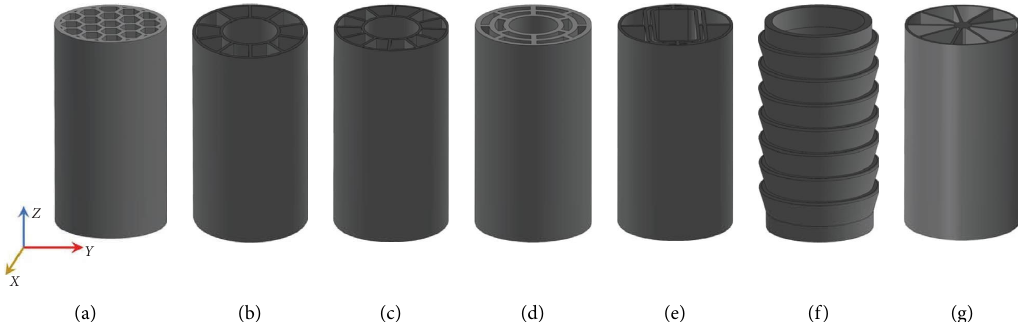
Figure 3: Te illustration of CAD models for nature inspired infll structures: (a) TIHIs, (b) HIIs-10, (c) HIIs-12, (d) BIIs, (e) CIIs, (f) PIIs, and (g)